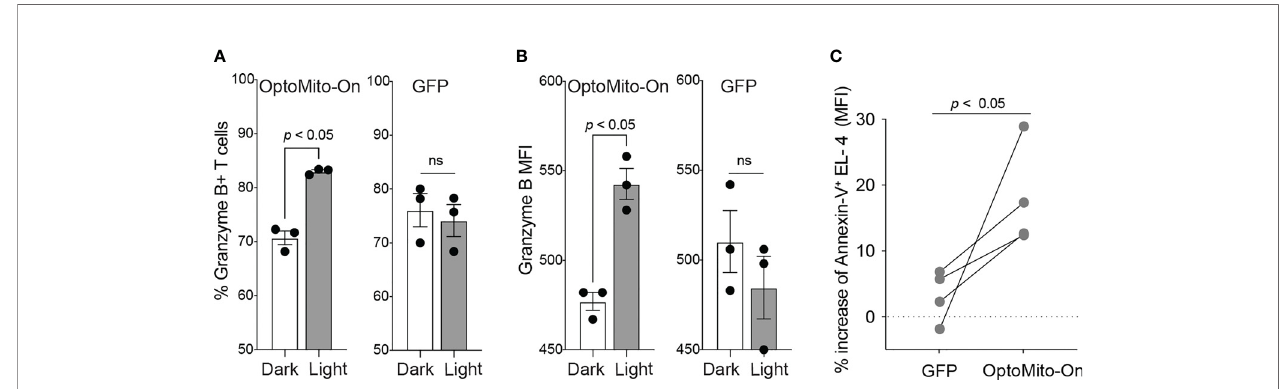
FIGURE 7 | OptoMito-On activation increases CD8 + T cell effector functions. Flow cytometry results from an 18-hour light activation of GFP or OptoMito-On expressing CD8 + T cells looking at the percentage of Granzyme B+ cells (A) and Granzyme B MFI (B) (n = 3). (C) Flow cytometry results of a 3-hour co-culture of OVA pulsed EL-4 cells with GFP or OptoMito-On expressing OT-I T cells. The graph shows the percent change of Annexin-V MFI of EL-4 cells from the dark to light condition. OT-I T cells were either kept in the dark or received 16-17 hours of 530 nm light before the addition of EL-4 cells. All data shown as mean ± SEM, A-B analyzed by One-Way ANOVA with a Bonferroni post-test, C analyzed by one-tailed paired t test ( A, B : representative of two experiments, C : four independent experiments). ns, not signi fi